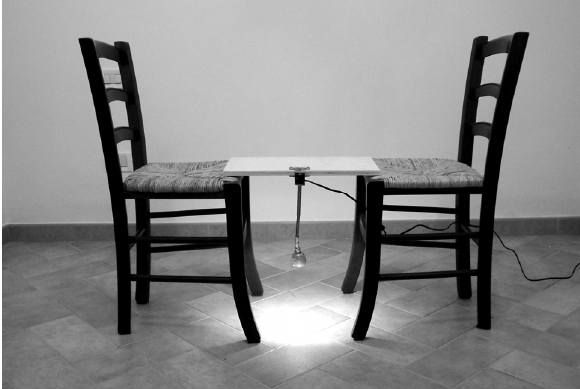
Figure 2. The interpersonal symmetric setting used for inter-subjective strange-face illusions [28]. The subject’s task is to stare into the eyes of the other